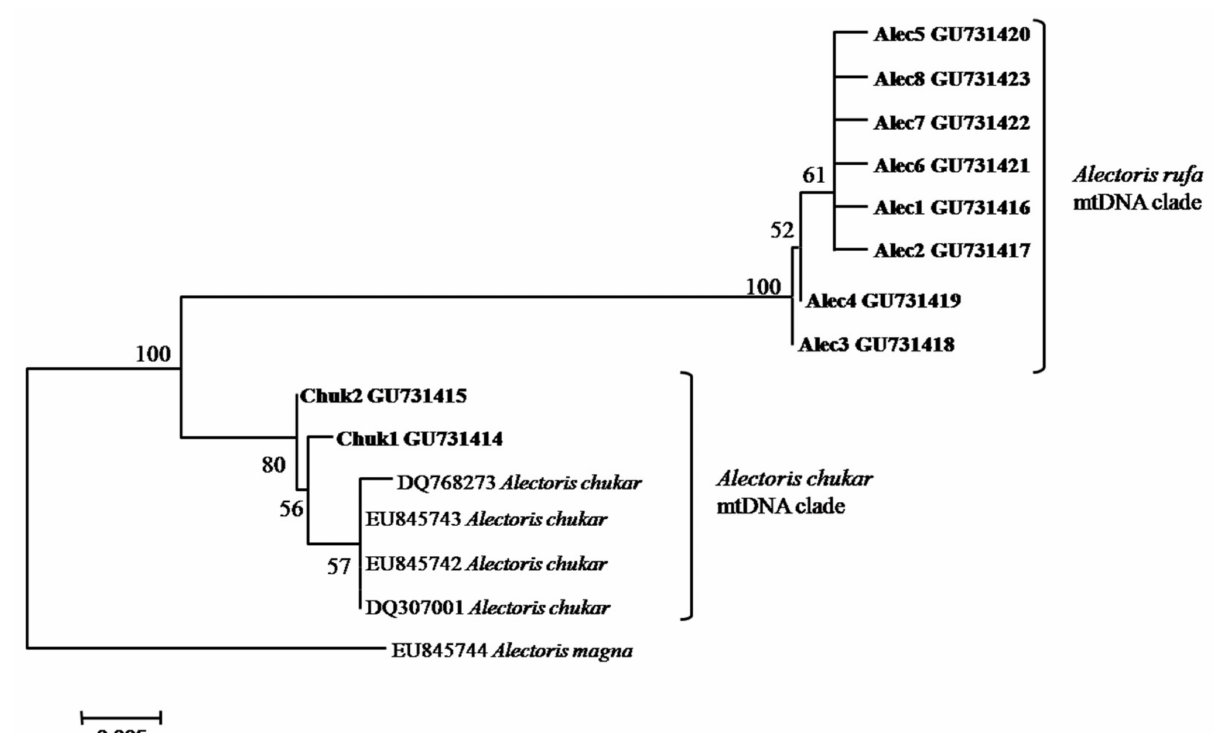
Figure 3. Neighbour-joining tree of mtDNA haplotypes from samples classified morphologically as Alectoris rufa (in bold). The tree was rooted using the Alectoris magna sequence (Genbank accession numbers of sequences are indicated on the tree). Bootstrap support to internal branches (>50; 10, 000 replicates) is indicated by